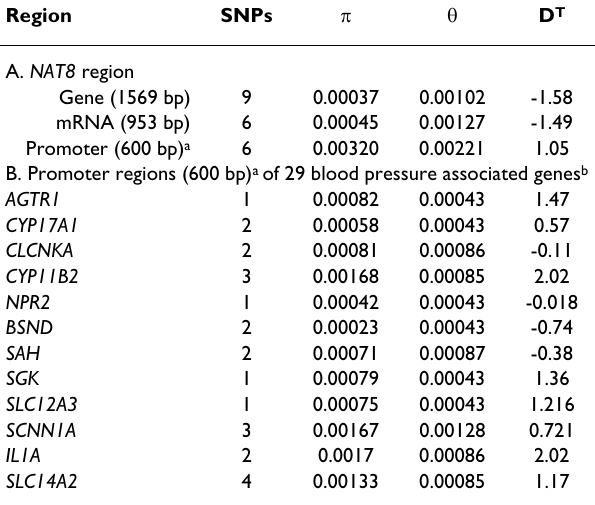
Table 3: Diversity parameters for resequenced NAT8 gene and promoter regions of 29 genes associated with blood pressure